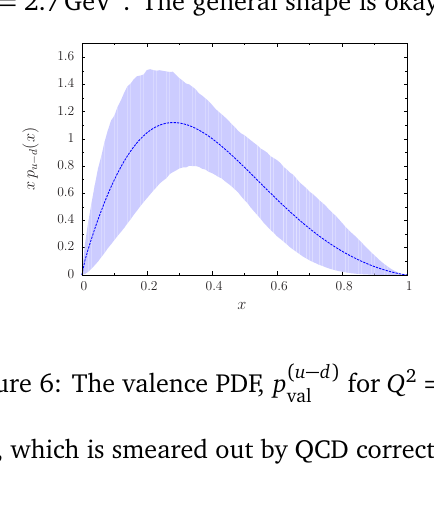
Figure 5: LH panel: The first 5 isovector moments M for various Q 2 values). RH panel: The corresponding valence PDF for M Q 2 = 2.7GeV 2 , together with the fit from eq. (21).